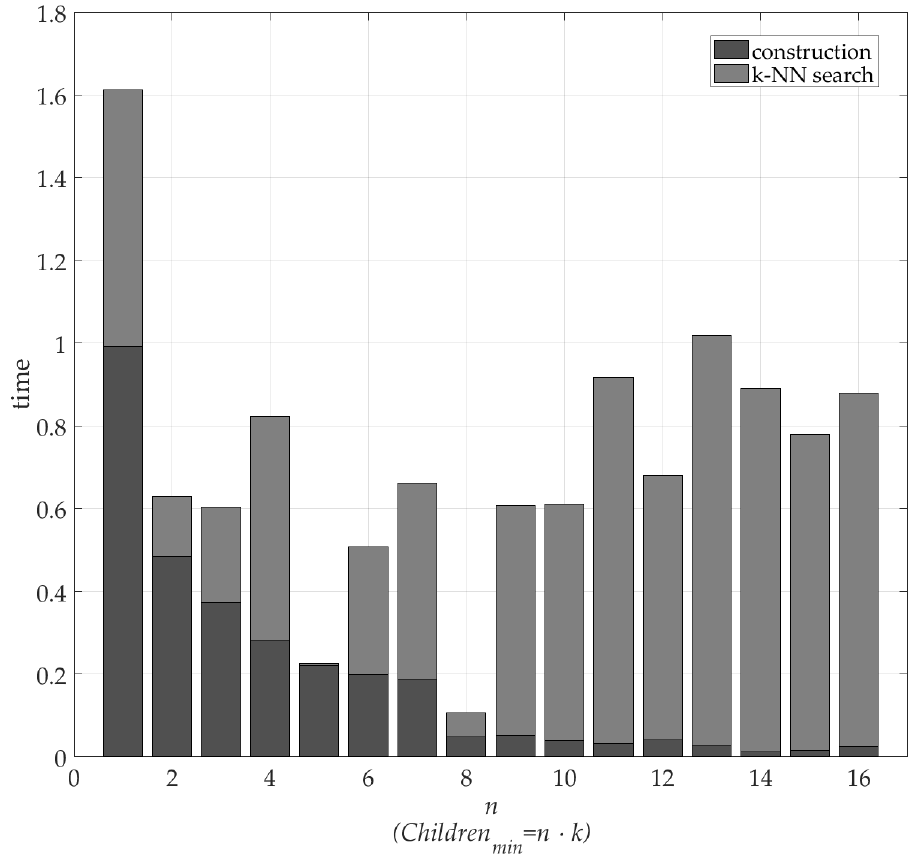
Figure 5. Thresholds